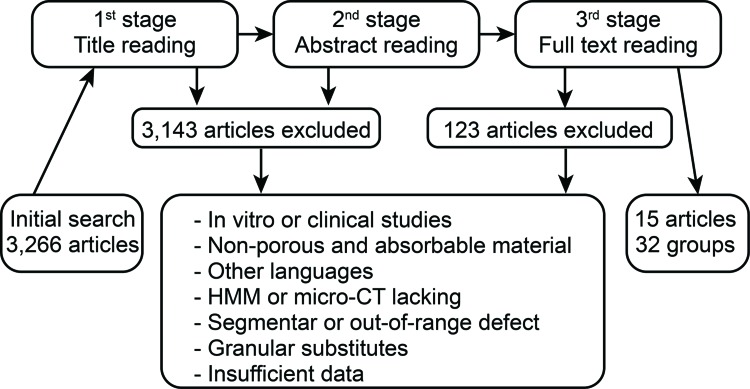
Search strategy.